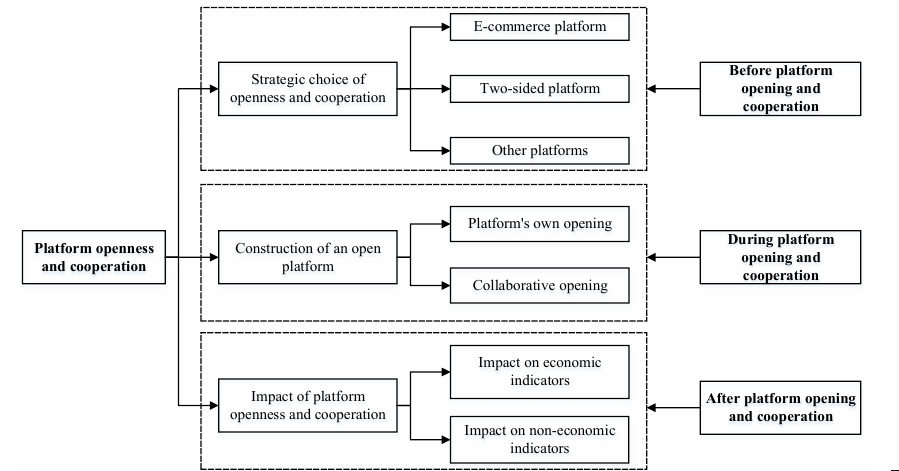
Figure 8. Research themes of platform opening and